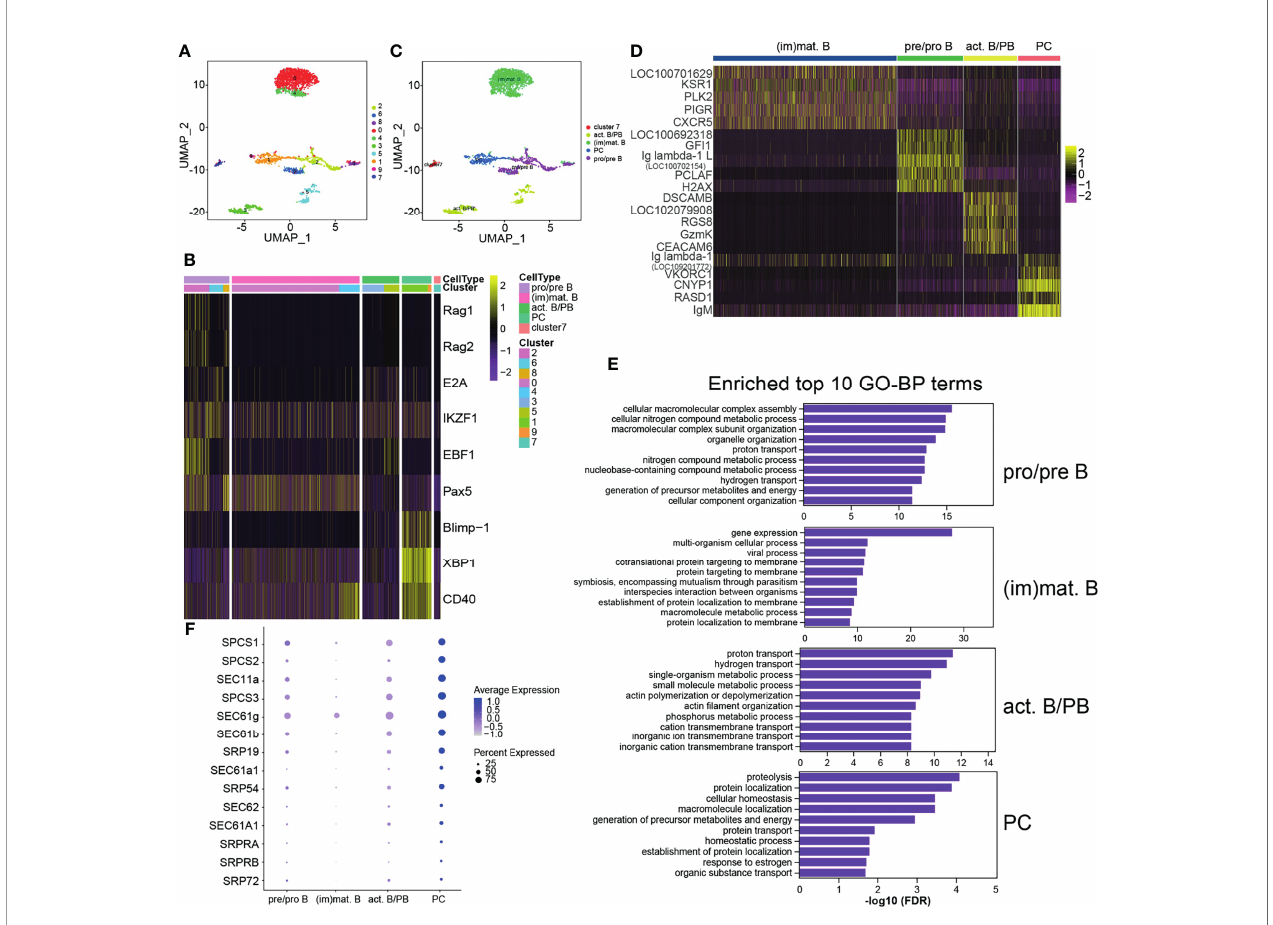
FIGURE 2 | Heterogeneous subsets in B cells. (A) The identi fi ed whole B cells were classi fi ed into 10 different clusters and shown with a uniform manifold approximation and projection (UMP) space. The clusters were obtained with a resolution of 0.3. (B) Heatmap of the different expressions of the genes used to identify the B-cell subsets. The clusters were identi fi ed into four B-cell subsets: pre/pro B, immature/mature B cells [(im)mat. B)], activated B cell and plasmablasts (act. B/PBs), and plasma cells (PCs). The remaining small group in cluster 7 was not identi fi ed. (C) Distribution of the identi fi ed B-cell subsets in UMAP space. (D) Heatmap of the top 5 most signi fi cant speci fi c genes for each B-cell subset. (E) The top 10 most signi fi cant Gene Ontology (GO) terms within the biological process (BP) category for each B-cell subset. (F) Bubble chart of the enriched protein transport genes in B-cell